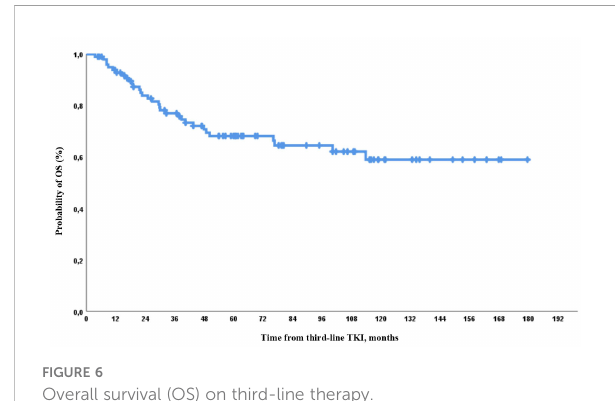
FIGURE 6 Overall survival (OS) on third-line